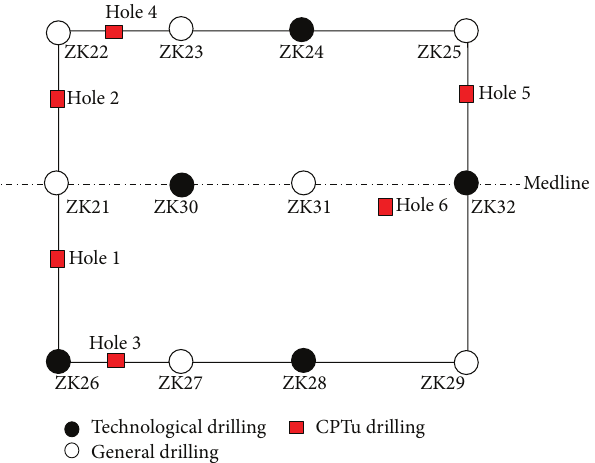
Figure 4: Layout diagram of CPTu holes in Yangtze River four bridge north anchorage.